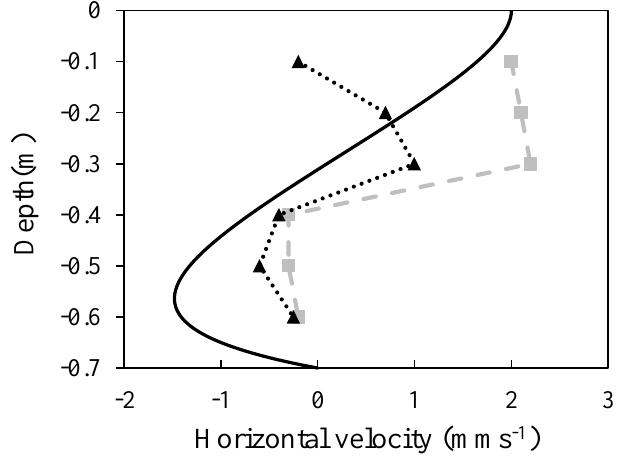
Figure 8. Comparisons of horizontal velocity profiles between the asymptotic solutions (solid lines) and data from [22] (dash and dot lines).